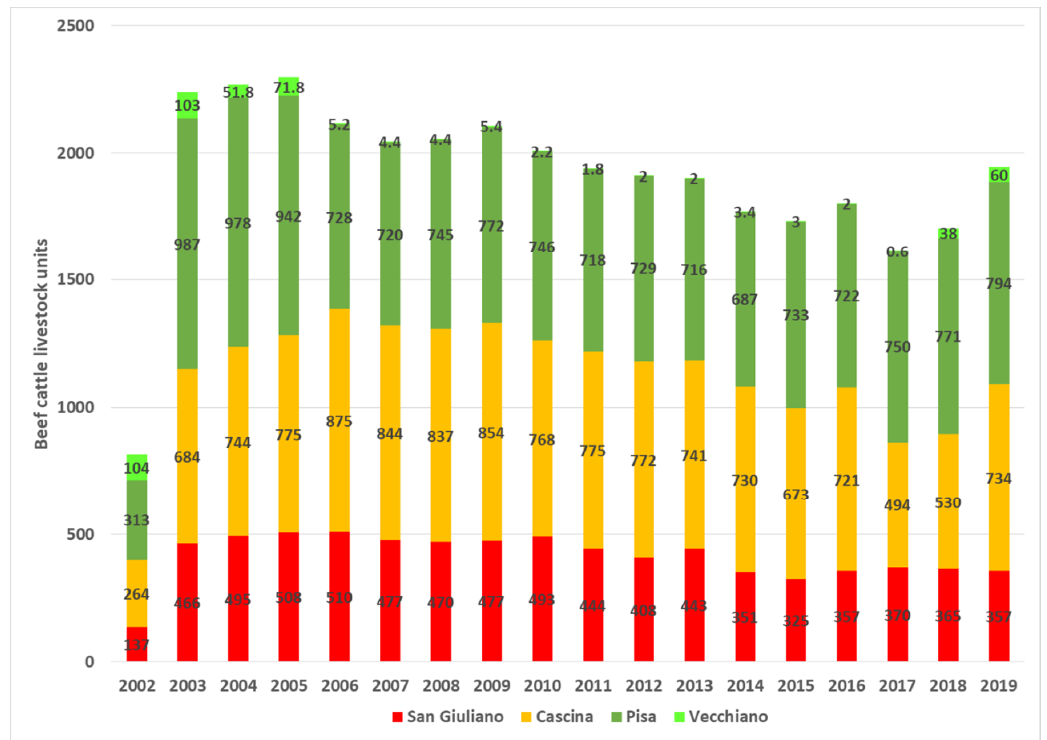
Figure 4. Short-term dynamics of beef cattle livestock units in the four most livestock-oriented municipalities of peri-urban area of Pisa (Italy). Source of the data: Istituto Zooprofilattico Sperimentale, 2020.